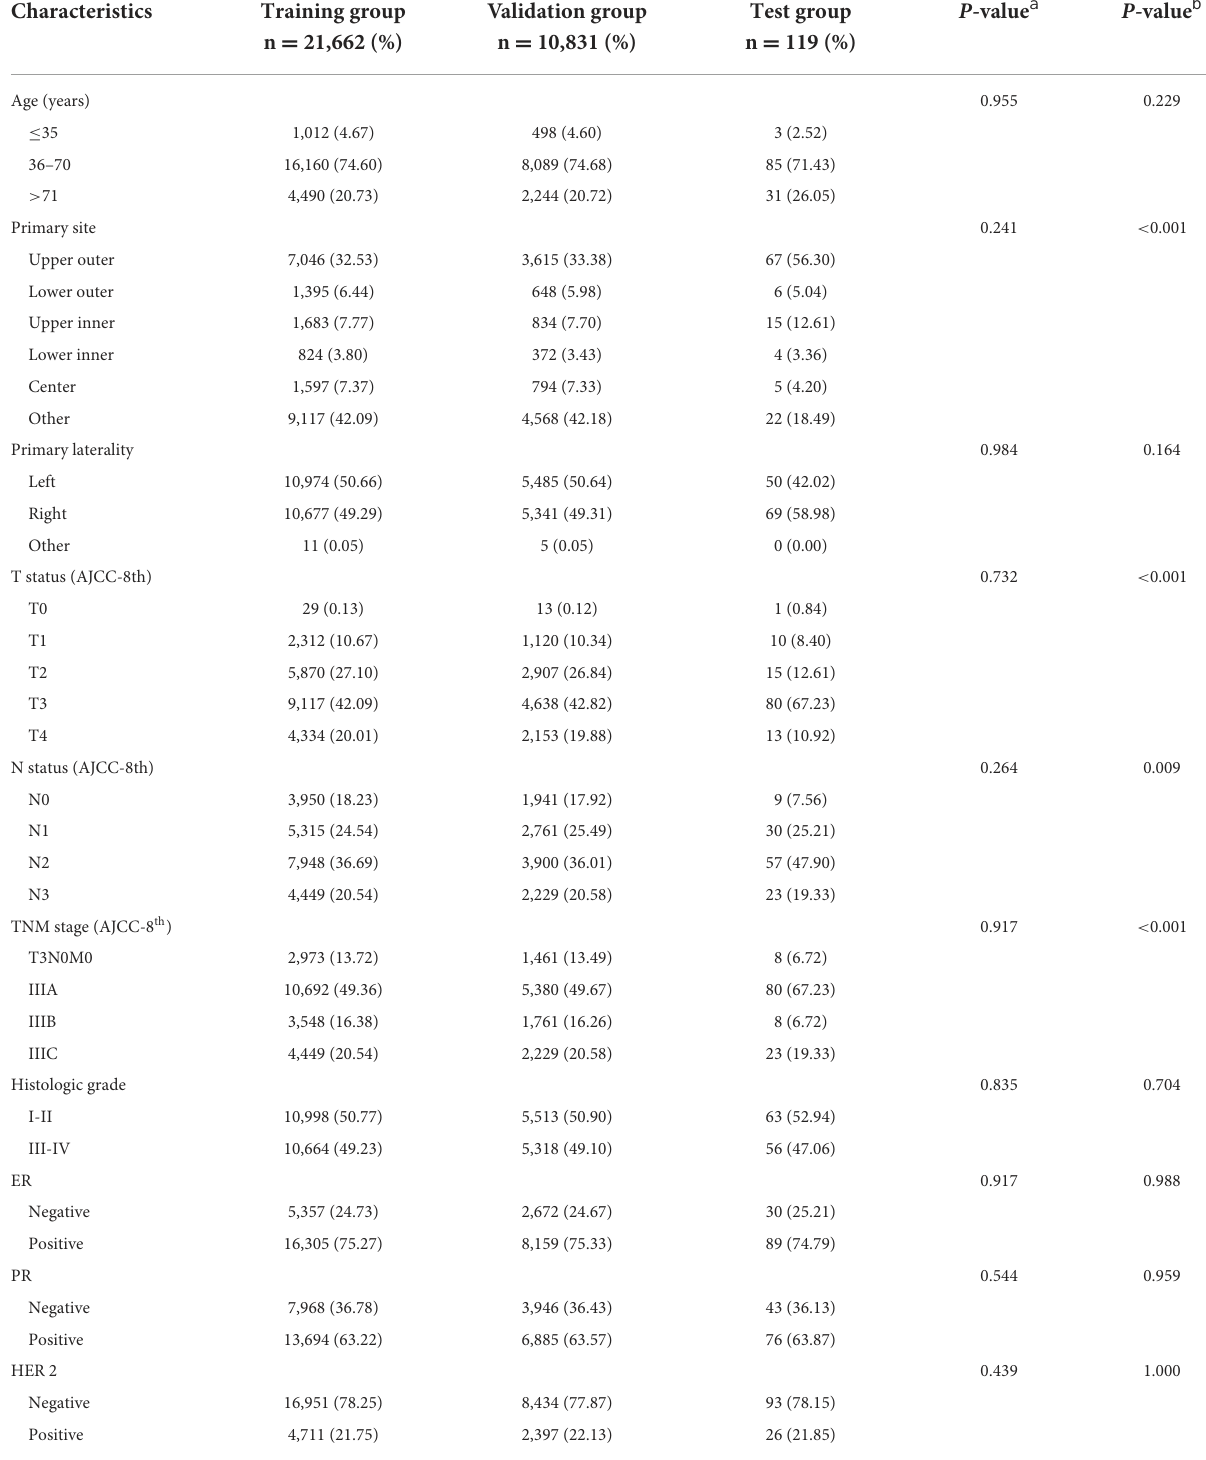
TABLE 1 Patient clinicopathologic characteristics in locally advanced breast